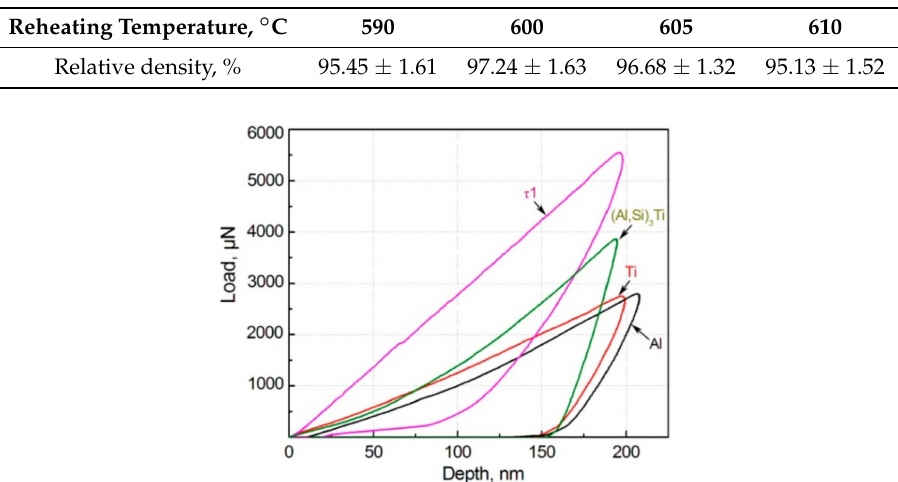
Table 1. Relative densities of the composites thixoformed at different reheating temperatures.